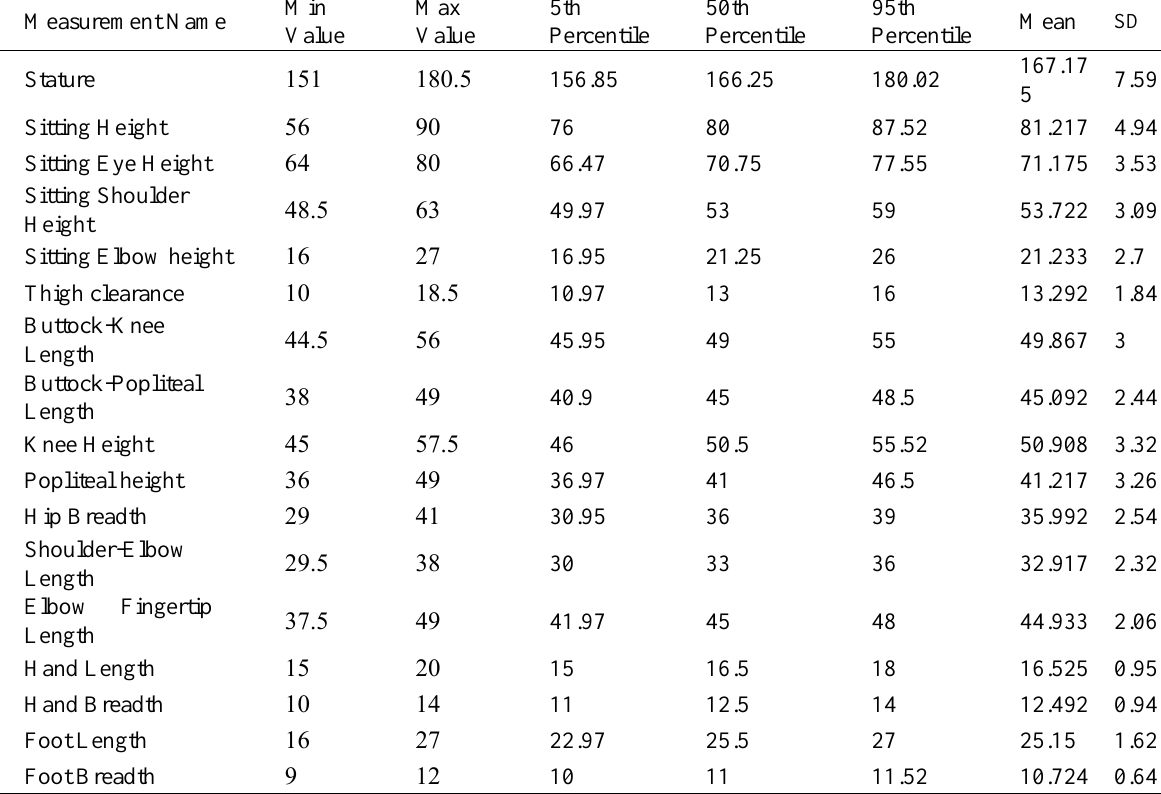
Table 2. Statistical approach for the anthropometric measurement of male official